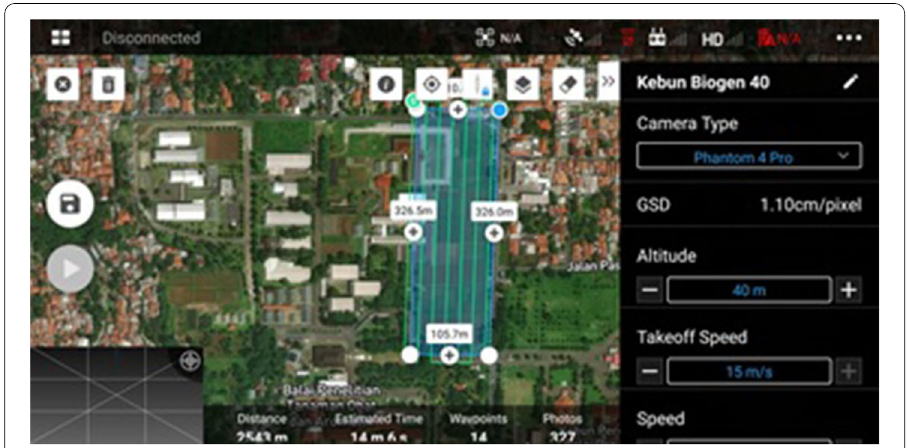
Fig. 4 Images from DJI Pilot showing area of Tennis court at Bogor, Indonesia, we take 3 data with an altitude of 40, 80, and 100